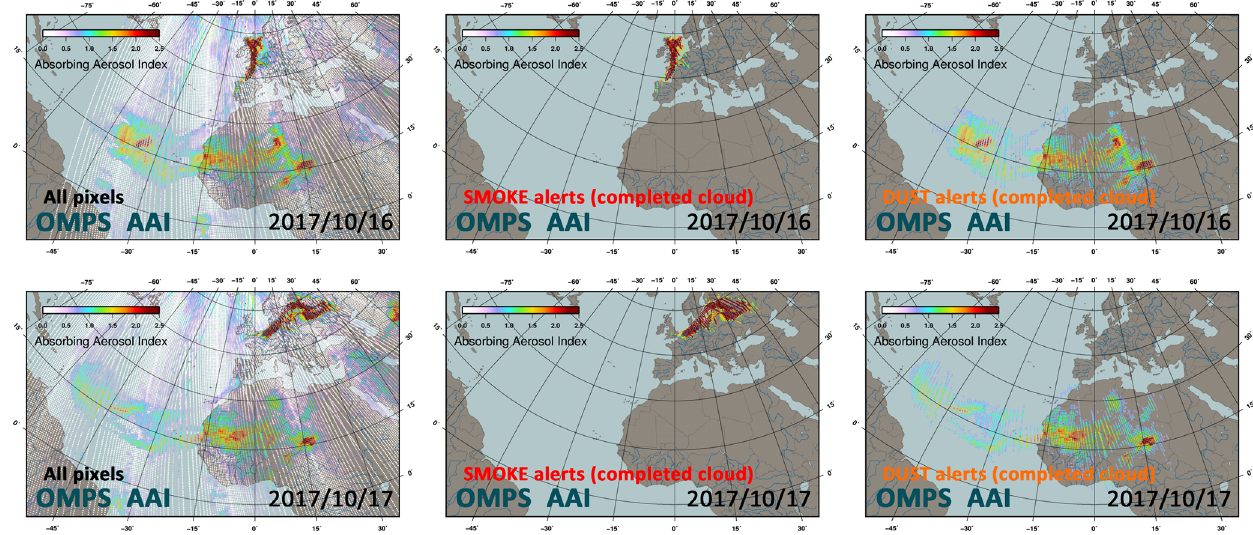
Figure 12. Isolated OMPS AAI pixels related to dust and smoke on 16 and 17 October 2017. Please note that the date format in this figure is